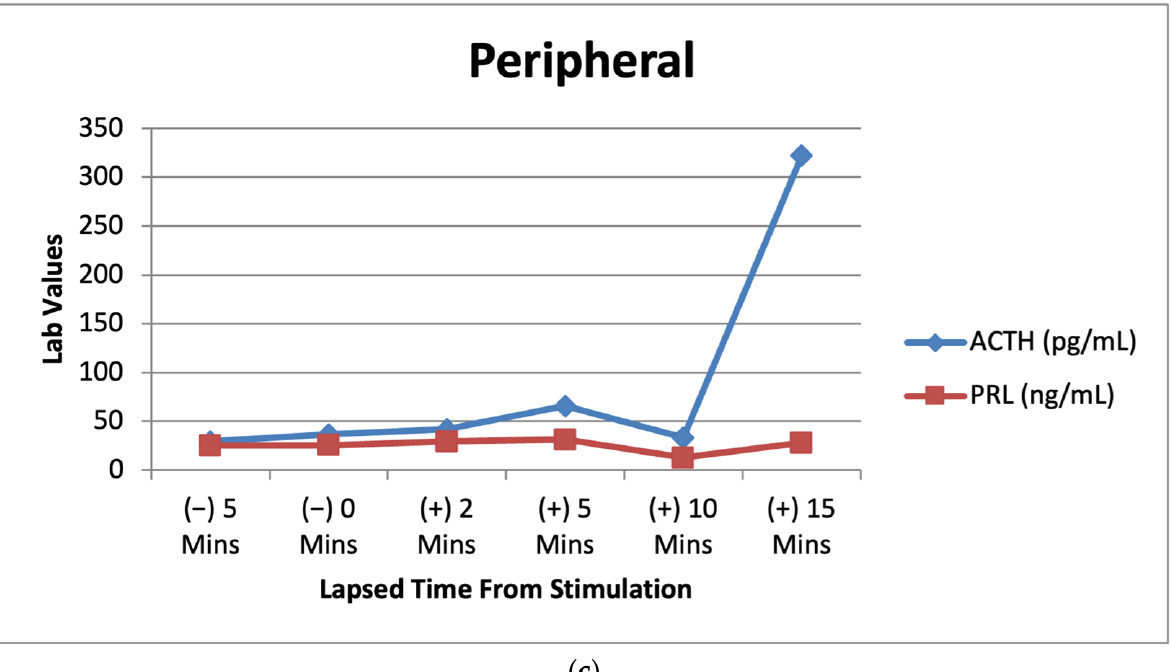
Figure 3. ( a ) Right IPS venous sampling values for ACTH and prolactin after CRH stimulation over multiple time intervals. ( b ) Left IPS venous sampling values for ACTH and prolactin after CRH stimulation over multiple time intervals. ( c ) Peripheral sampling values for ACTH and prolactin after CRH stimulation over multiple time intervals.